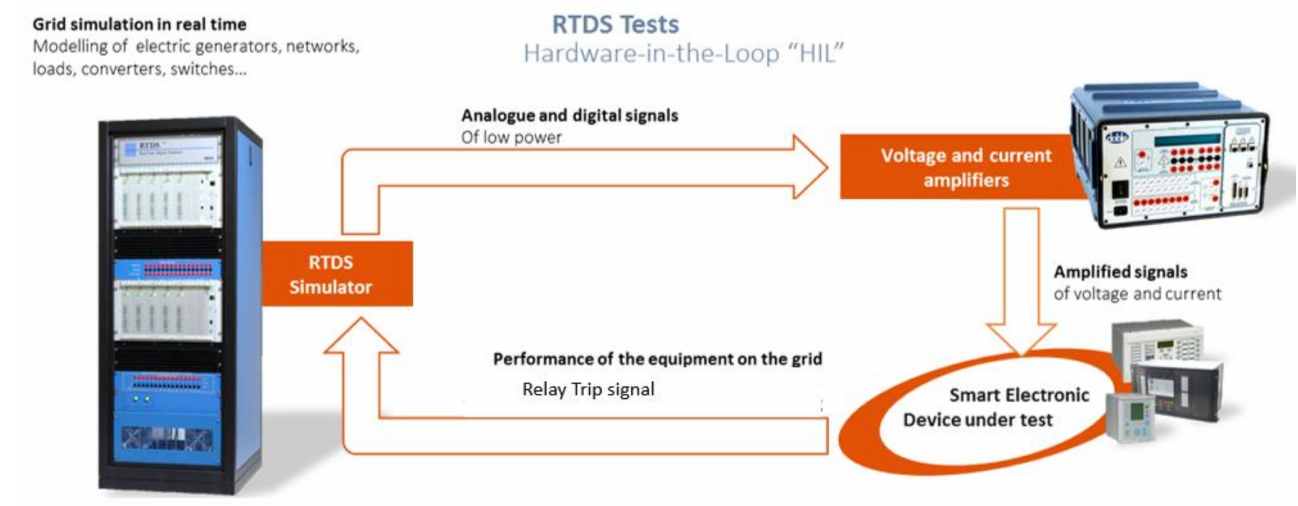
Figure 10. Hardware in the loop configuration.